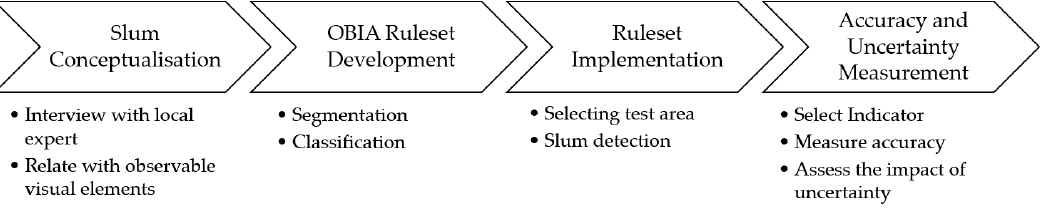
Figure 2. Research methodology comprised of four main parts and their following activities.